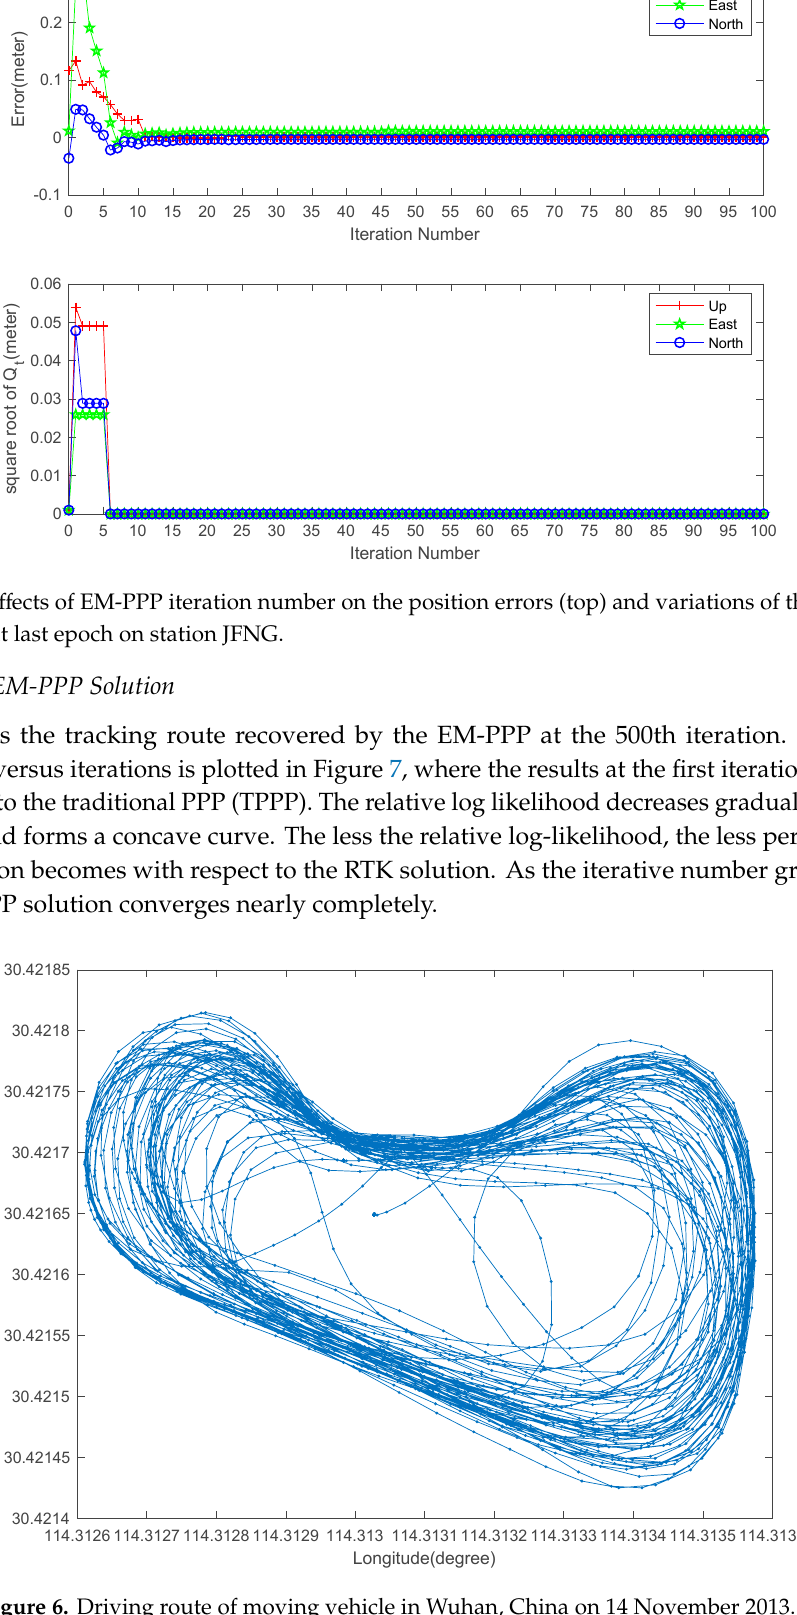
Figure 7. Relative log-likelihood of two consecutive iterations. Illustrated in Figure 8 are the positioning errors of the traditional PPP solution and EM-PPP solution at the 500th iteration with respect to the reference coordinates in the Up, East and North directions. It is observed that EM-PPP solutions are much more stable in all directions when compared to TPPP solutions. The TPPP solution in the East changes wobbly in comparison to the North and Up due to greater acceleration in the East (Figure 9), which leads to a larger bias in the East. In fact, the position and velocity (PV) model of our kinematic state equation is assumed to be a constant velocity model, which means the acceleration is zero. However, the realistic acceleration of the vehicle is no zero, which results in systematic bias and unstable solution.